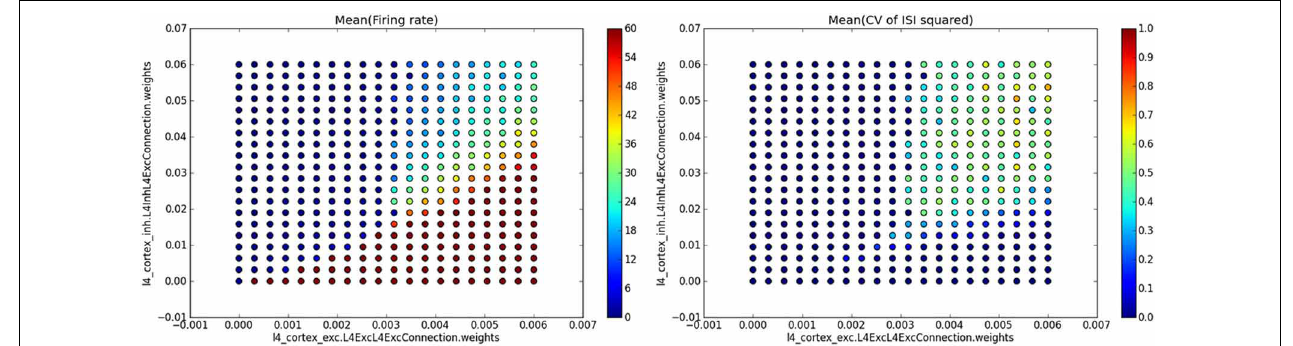
FIGURE 6 | Example of automatic plotting of parameter search results. Method single_value_visualization plots the values from SingleValue ADSs as a function of the parameters that were varied (see the axis labels in the plots which specify the full path of the parameter in the parameter hierarchy), creating one subplot for each value of parameter value_name (see titles of the subplots). In this specific example we ran a simulation of the Vogels and Abbott (2005) model, while varying the strength of